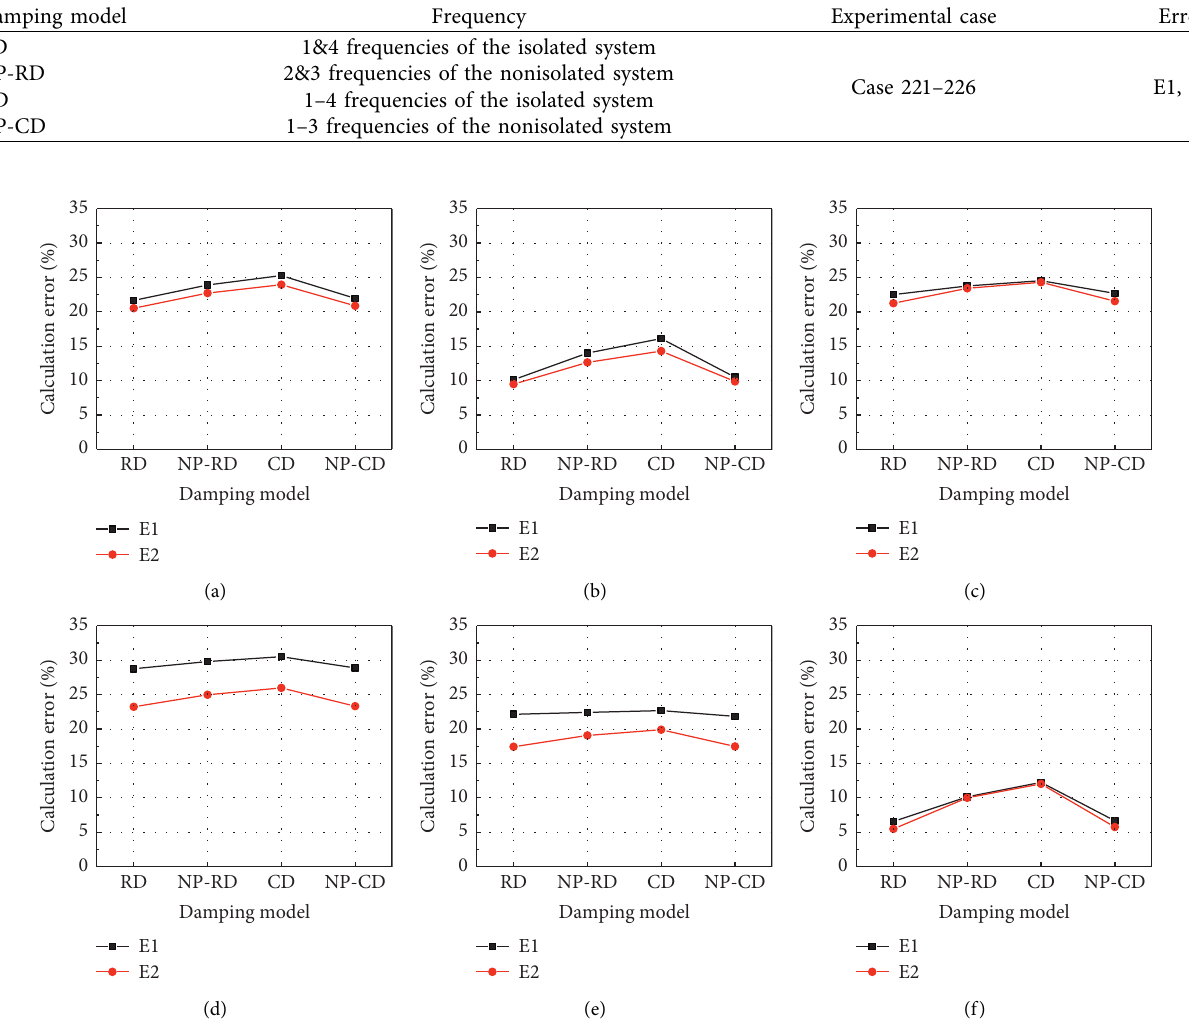
Figure 14: Calculation errors of isolation displacement by using different damping models (PGA � 0.2 g): (a) case 221, (b) case 222, (c) case 223, (d) case 224, (e) case 225, and (f) case